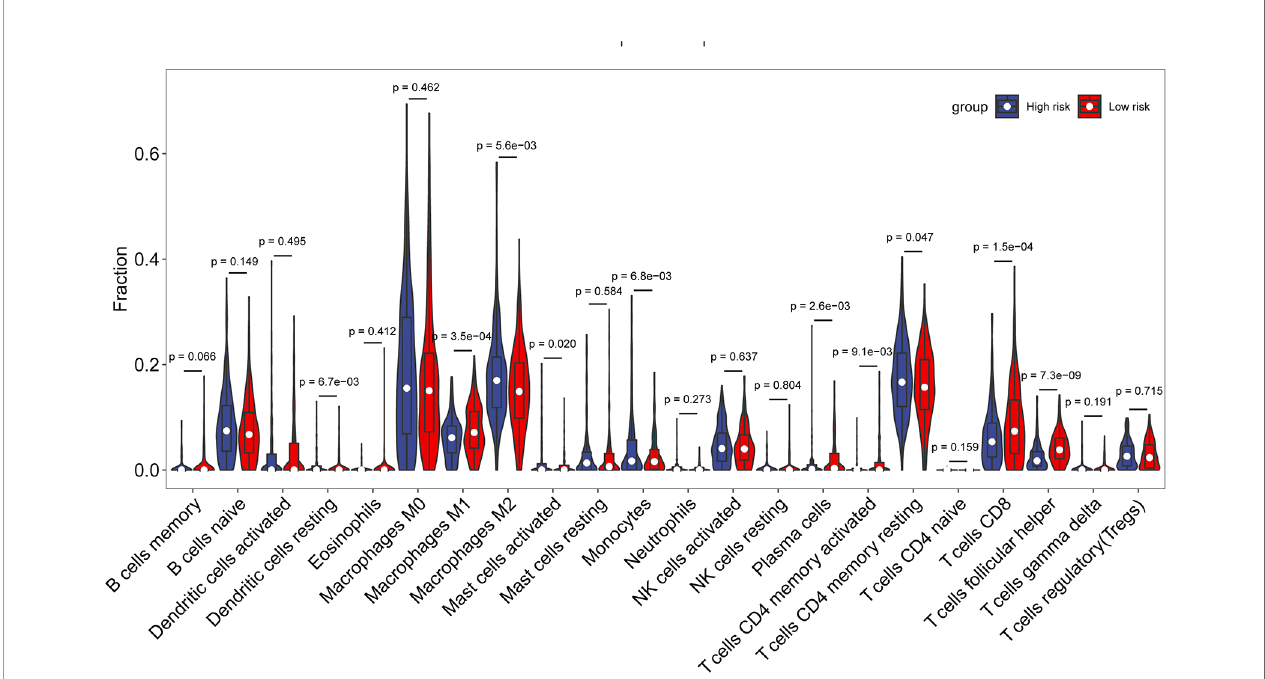
FIGURE 6 | Comparison of immune cell composition between the high- and low-risk